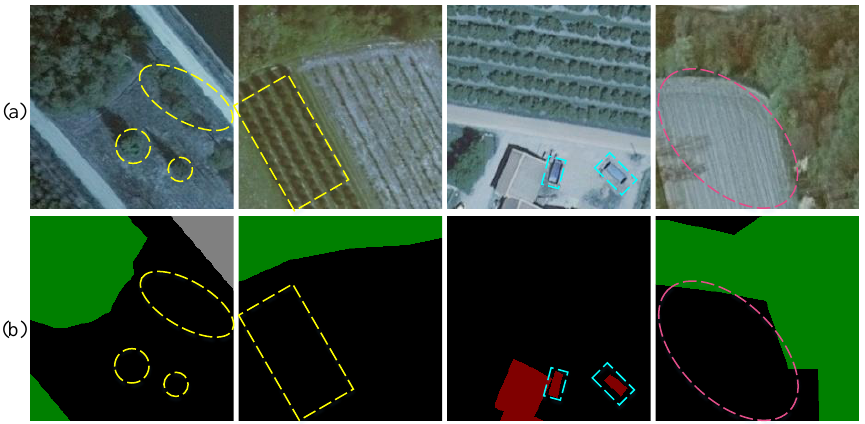
Figure 9. An example from the LandCover dataset. ( a ) Original image; ( b ) artificial label. The parts shown by the dotted line belong to the background class, though they are easily misclassified. The objects encircled by the solid line are the target classes, though they are easily misrecognized as